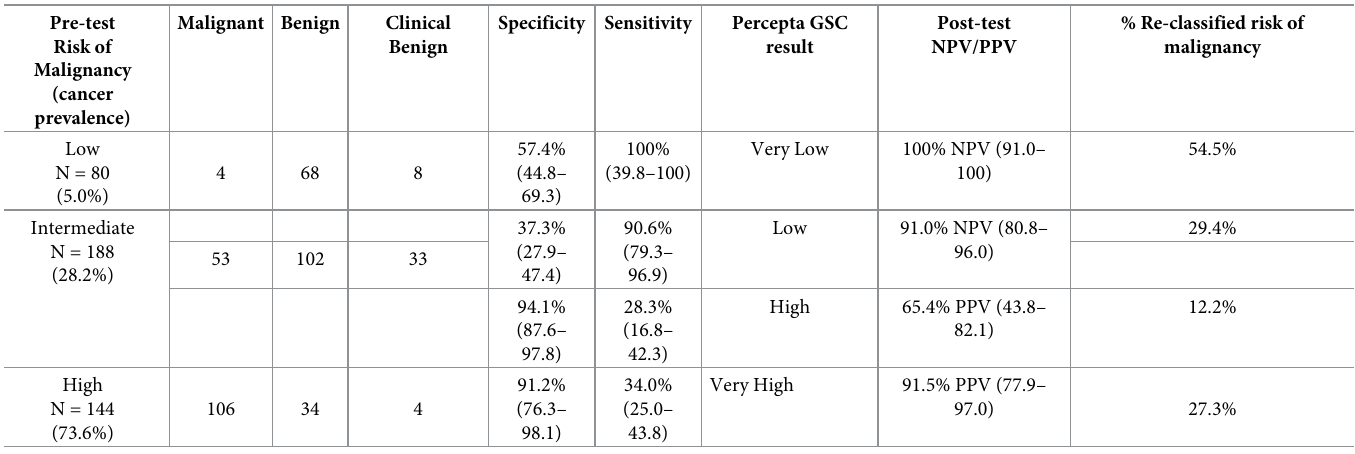
Table 2. Percepta GSC